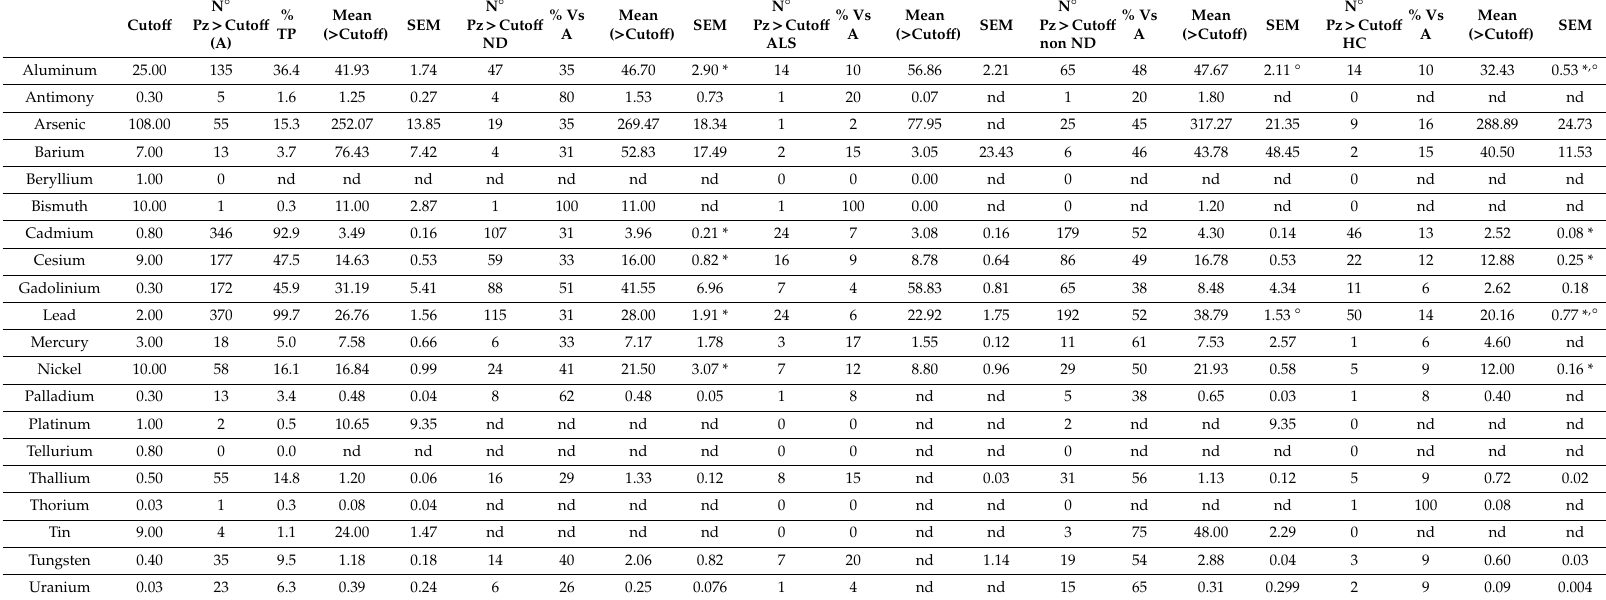
Table 1. Toxic-metal burden values assessed in the urine samples taken from patients following the chelation test. The cuto ff represents the limit values of toxic metals, as higher values indicate toxicity. Patients with toxic-metal values above the cut-o ff are reported in the column 3 and indicated as A for each toxic metal in the total population (TP = all patients examined). The percentage of intoxication by each toxic metal with respect to the TP is reported in column 4. Columns 5 and 6 respectively show the mean and standard error of the mean (SEM) of the metal level values above the cut-o ff . Columns 7 and 8 show the number of ND patients burdened with each toxic metal and the percentage of those patients vs. A. Columns 9 and 10 show the mean values of toxic-metal levels above the cut-o ff and the SEM in ND patients. Columns 11 and 12 show the number of ALS patients a ff ected by toxic-metal burdens (i.e., levels of toxic metals above the cut-o ff ) and their percentage vs. A. Columns 13 and 14 show the mean values and SEM of toxic-metal levels above the cut-o ff in ALS patients. Columns 14 and 15 show the number of patients a ff ected by each toxic-metal burden and their percentage vs. A in non-ND patients. Columns 16 and 17 show the mean values of toxic-metal levels above the cut-o ff and SEM in non-ND patients. Columns 18 and 19 show the number of patients a ff ected by toxic-metal burdens relative to each toxic metal and their percentage vs. A in HC patients. Columns 20 and 21 show the mean values and SEM of toxic-metal levels above the cut-o ff in HC patients. * p < 0.05 HC vs. A and ◦ p < 0.05 HC vs. non-ND. A = number of patients with toxic metal levels > cut-o ff for each toxic metal. TP = total population, e.g., all patients examined. ND = patients a ff ected by neurodegenerative diseases. Non-ND = patients a ff ected by non-neurodegenerative diseases. HC = healthy controls. ALS = patients a ff ected by amyotrophic lateral sclerosis.